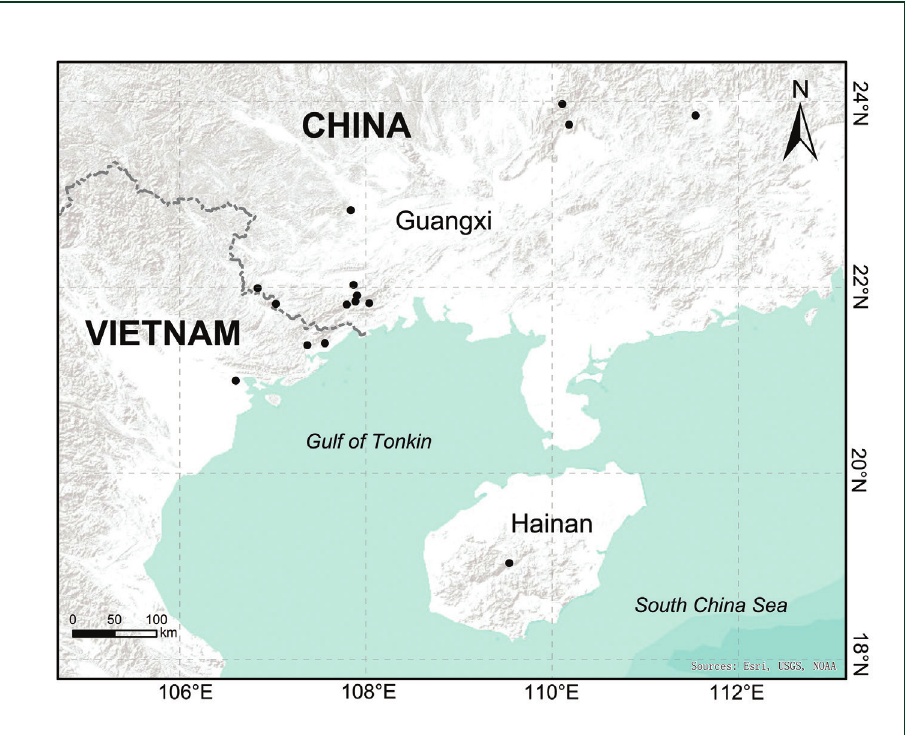
Figure 5. Distribution map of Selaginella guihaia X.C.Zhang, sp. nov.